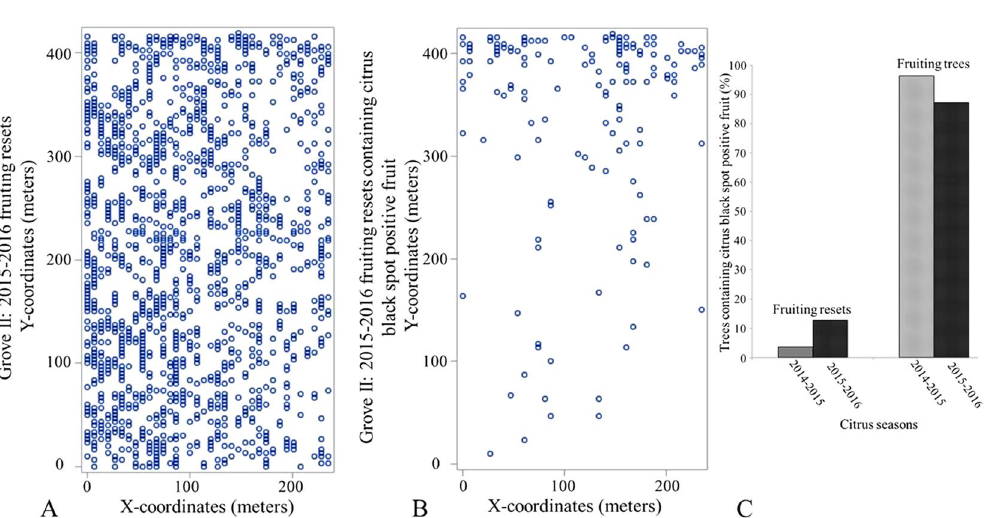
Figure 3. Grove II: Fruiting resets for the 2015–2016 citrus season. ( A ) – Spatial distribution of fruiting resets (open circles). Quadrat analysis of fruiting resets regardless of CBS status indicated random distribution of fruiting resets for 2 × 2 tree quadrats (dispersion index, D = 1.02; p-value = 0.347). For quadrat sizes 3 × 3 trees to 10 × 10 trees fruiting resets were statistically significantly clustered with dispersion indices, D ranging from 1.32 to 4.15; p < 0.001 for all quadrats. ( B ) – Spatial distribution of fruiting resets with fruit positive for citrus black spot (open circles). Quadrat analysis indicated disease clustering in fruiting resets with fruits positive for citrus black spot for all quadrat sizes tested (2 × 2 trees to 10 × 10 trees; D ranging from 1.25 to 11.03, p < 0.001 for all quadrat sizes). ( C ) – Column chart comparing the proportion of trees classified as fruiting resets and fruiting trees containing at least one fruit with a single hard-spot lesion in the 2014–2015 and 2015–2016 citrus season. Fruiting resets represent resets fruiting for the first time in their respective